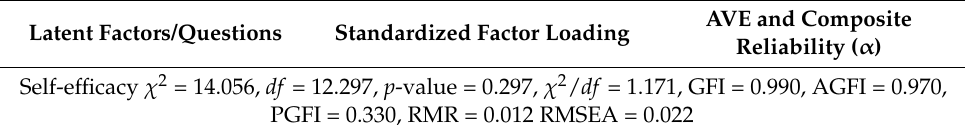
Table 1. Results of confirmatory factor analysis of the latent factors used in model